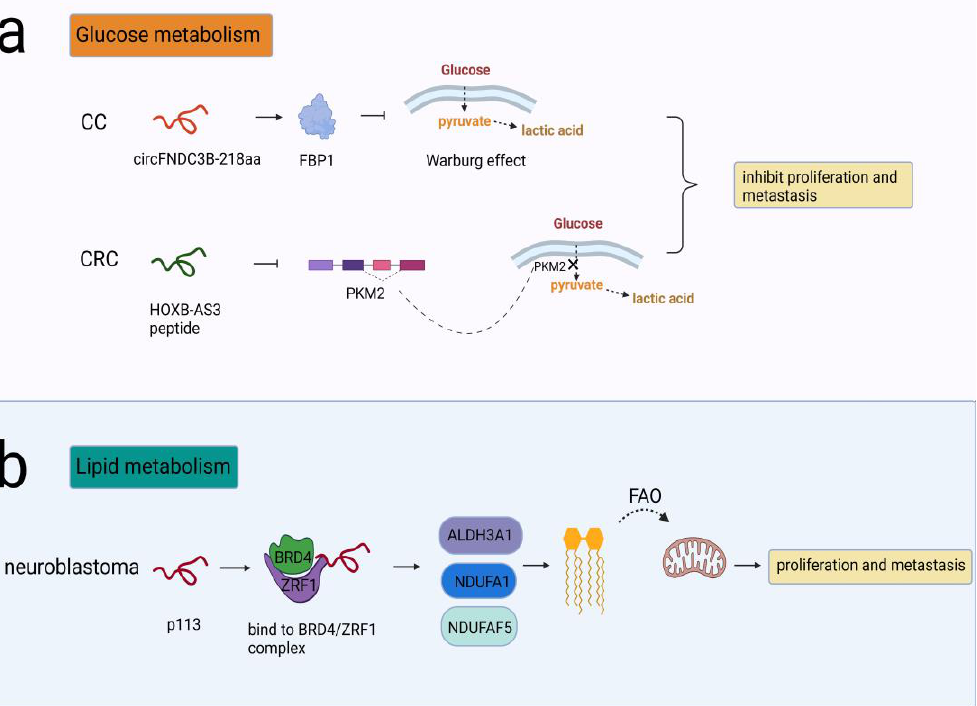
Figure 3. NcRNA-encoded peptides/proteins regulated cellular metabolism. ( a ) CircFNDC3B- 218aa enhanced FBP1 and alleviated the Warburg effect, prohibiting proliferation and metastasis in CC; HOXB-AS3 peptide suppressed PKM splicing and PKM2 formation that was critical to the reprogramming of glucose metabolism, prohibiting proliferation and metastasis in CRC. ( b ) p113 combined with ZRF1/BRD4 to activate ALDH3A1, NDUFA1, and NDUFAF5 that were needed in conversion of fatty aldehydes into FAO, promoting proliferation and metastasis in neuroblastoma.